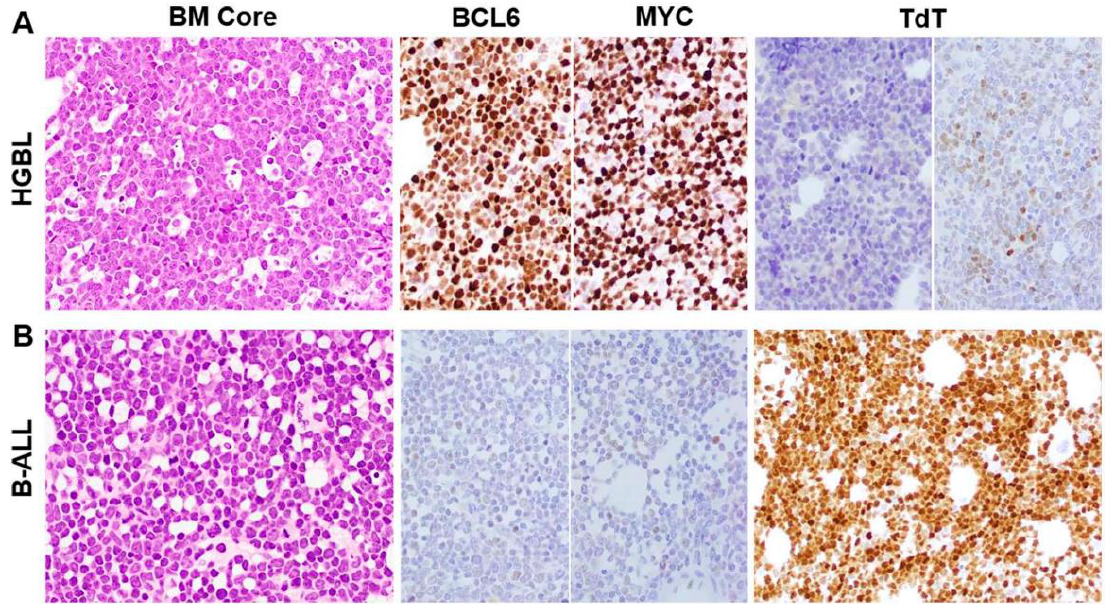
Figure 1. Comparison of morphologic and immunohistochemical features between blastoid HGBL and B-ALL. A representative case of blastoid HGBL ( A ) showed marrow space being entirely replaced by blastoid lymphoma cells with a starry sky pattern and strongly and diffusely positive for BCL6 and MYC but negative for TdT (left). Occasional blastoid HGBL may be variably positive for TdT in a small subset of lymphoma cells (right). In contrast, the lymphoblasts of a representative B-ALL case ( B ) showed similar blastoid morphology on core biopsy but had an opposite immunophenotypic profile featured by negative BCL6 and MYC and strong diffuse positive TdT. Magnifications: H&E, × 50; immunostains, ×